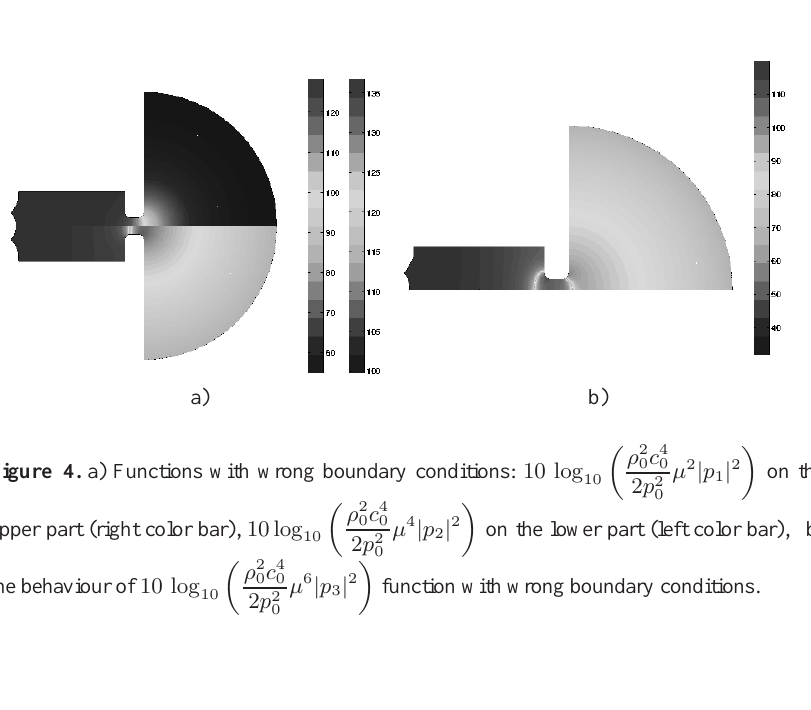
Figure 4. a) Functions with wrong boundary conditions: 10 log 10 upper part (right color bar), 10 log 10 the behaviour of 10 log 10